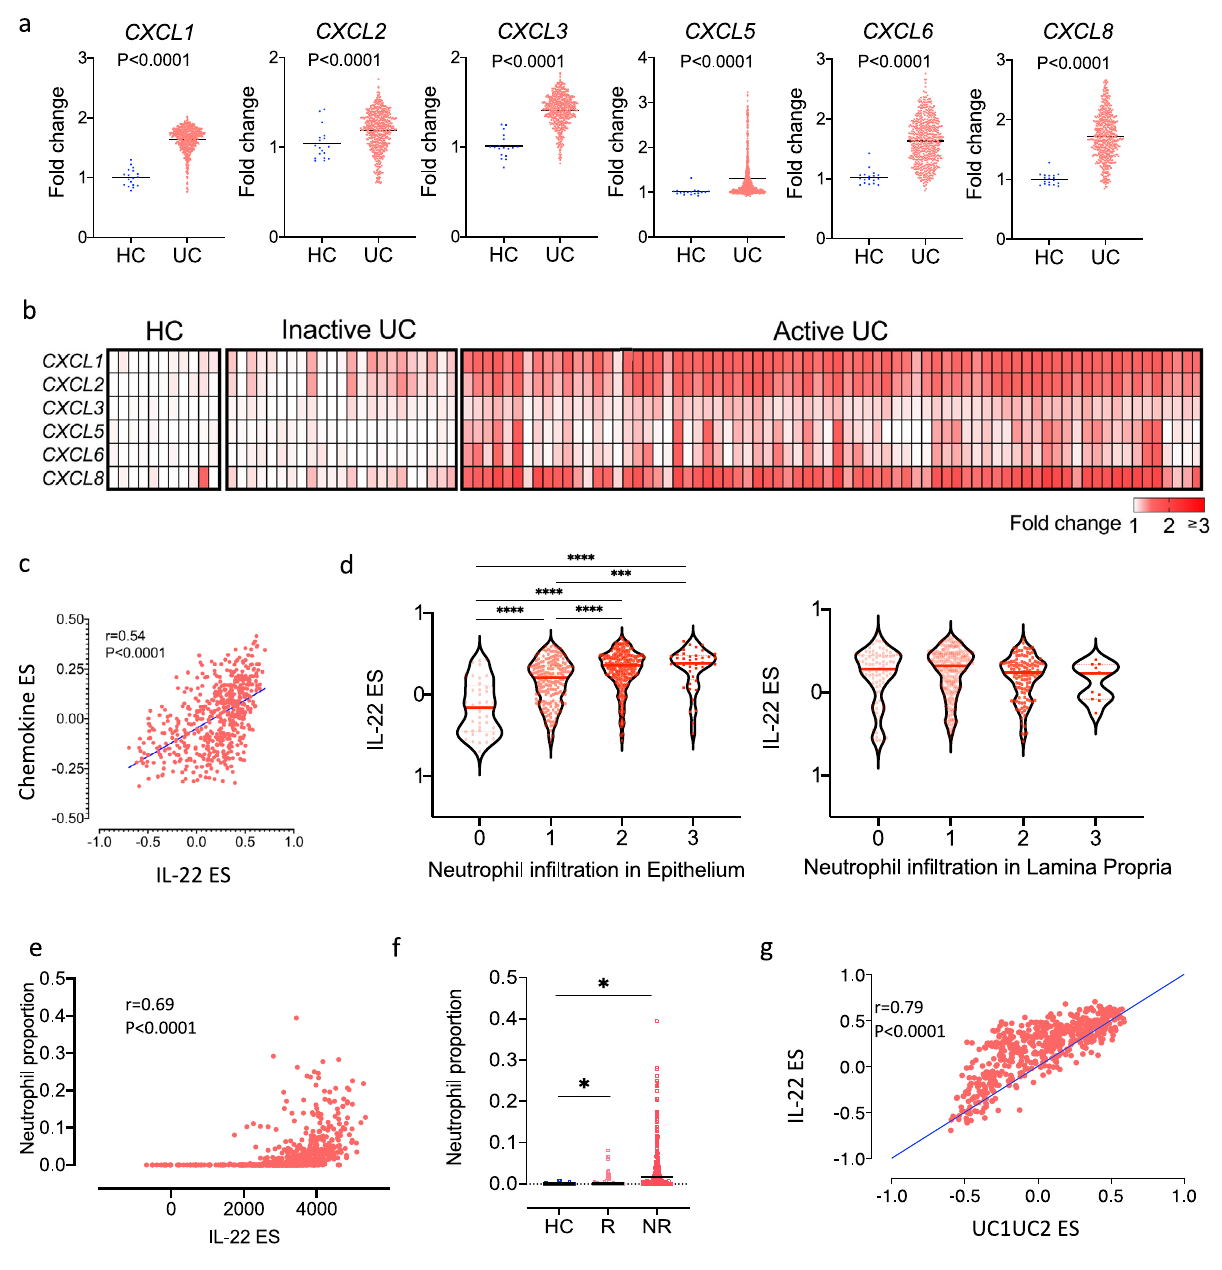
Fig. 4 | The IL-22 regulated transcriptome correlates with colonic neutrophil accumulation which is associated with resistance to ustekinumab therapy in ulcerative colitis. a Relative expression of neutrophil attracting chemokines in sigmoid biopsies of UC patientsparticipating tothe UNIFIstudy ( n =550)and non- IBDcontrols( n =18)(Mann – Whitneytest,two-tailed,nomultipletestingcorrection applied), b relative expression of the neutrophil attracting chemokines in the colonic mucosa of healthy controls (HC), UC patients with inactive and active disease (GSE50971), c non-parametric correlation (Spearman two-tailed) between the enrichment score for the IL-22 transcriptional program and the chemokine geneset( CXCL1,CXCL2,CXCL3,CXCL5,CXCL6,CXCL8 ), r =0.54,95%CI(0.48,0.60), d IL-22 enrichment scores strati fi ed by the neutrophil subscore of the Geboes histology score in the epithelium and lamina propria in colonic biopsies sampled from the UNITIcohortprior to starting ustekinumab. A higher subscore re fl ects an increase in neutrophil in fi ltration (for lamina propria 0: no increase, 1: mild but unequivocal increase, 2: moderate increase, 3: marked increase; for epithelium 0: none, 1: <5% crypts involved, 2: <50% crypts involved, 3: >50% involved)